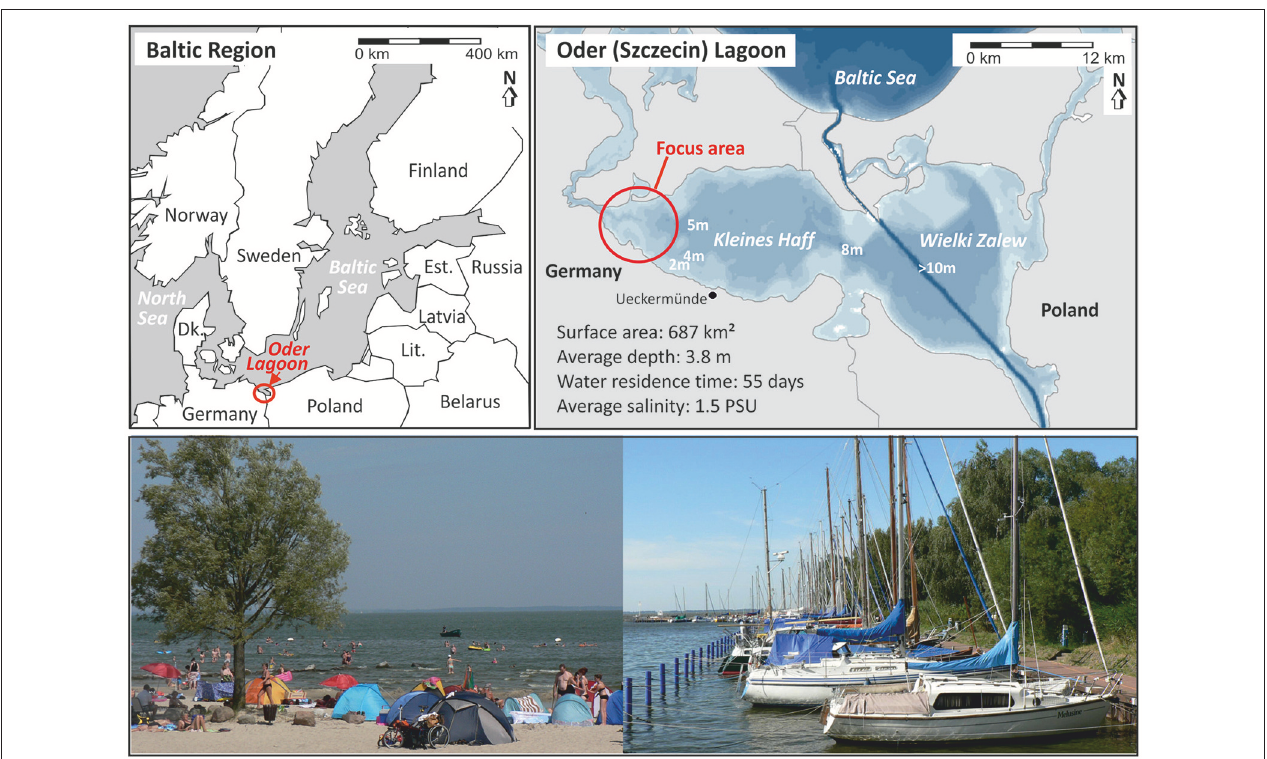
FIGURE 1 | Location of the Oder (Szczecin) Lagoon and the focus area and pictures showing the south-western lagoon coast near the small resort